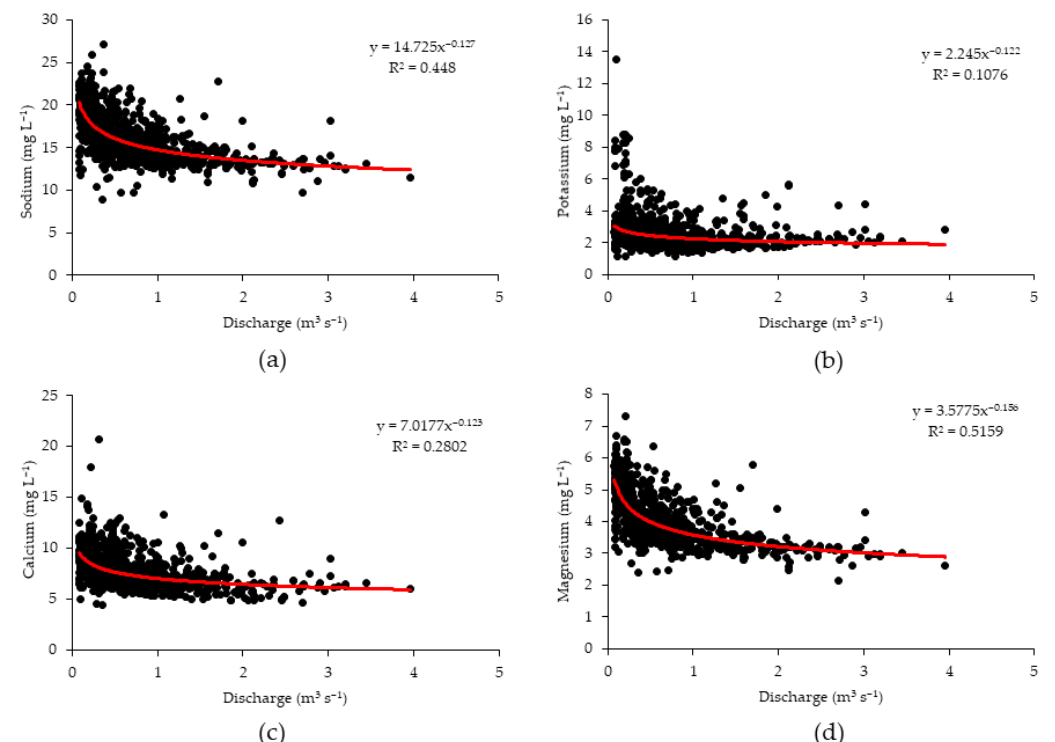
Figure 7. Concentration-discharge relationships for ( a ) sodium, ( b ) potassium, ( c ) calcium and ( d ) magnesium in the Valiñas catchment. Regression equations and coefficients are shown. When plotted on a log-log space (Figure 8), the four solutes showed a dilution be- havior with increasing discharge and no significant changes in the slope of the regression lines were observed when considering flows lower or greater than the median, except for the case of K + in which a reduction in the slope value was detected under high flow con- ditions.